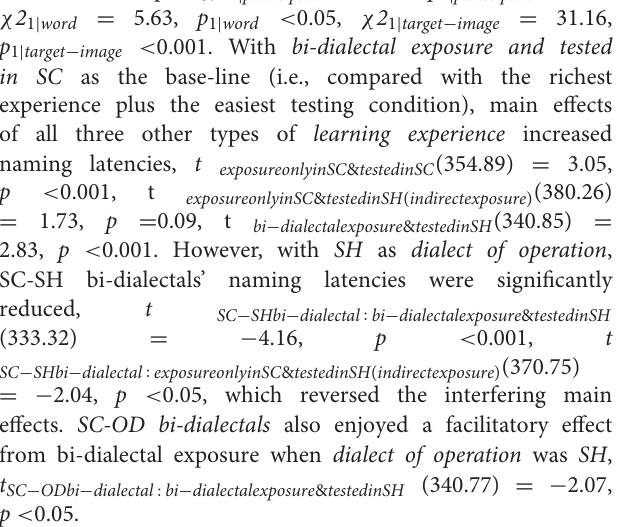
random intercepts, χ 2 1 | participant = 3.60, p 1 | participant =